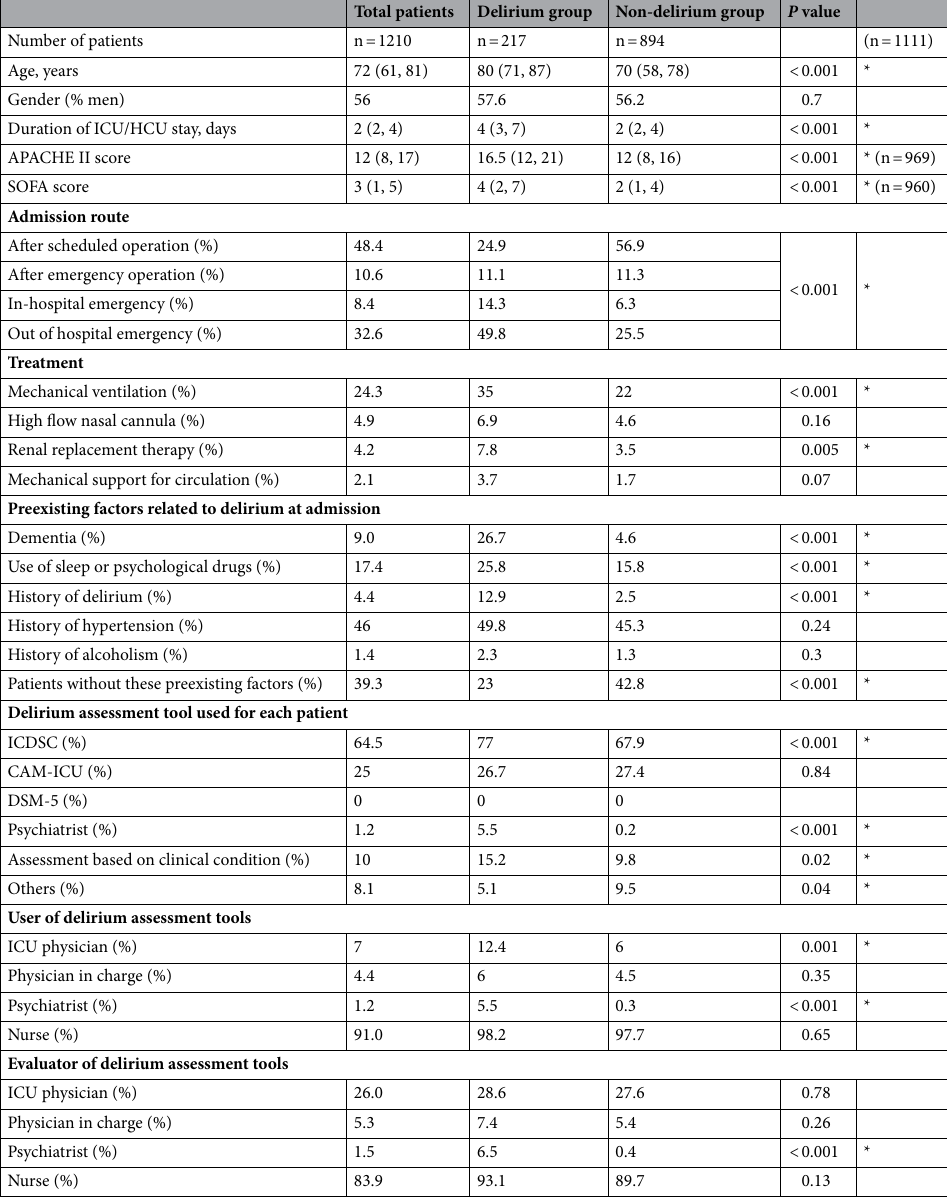
Table 3. Baseline characteristics of all patients, and comparison between delirium group and non-delirium group. * p < 0.05, APACHE Acute Physiology and Chronic Health Evaluation, SOFA Sequential Organ Failure Assessment, ICDSC Intensive Care Delirium Screening Checklist, CAM-ICU Confusion Assessment Method for the Intensive Care Unit, DSM-5 Diagnostic and Statistical Manual of Mental Disorders, Fifth Edition, ICU intensive care unit. Data are median (interquartile range) or